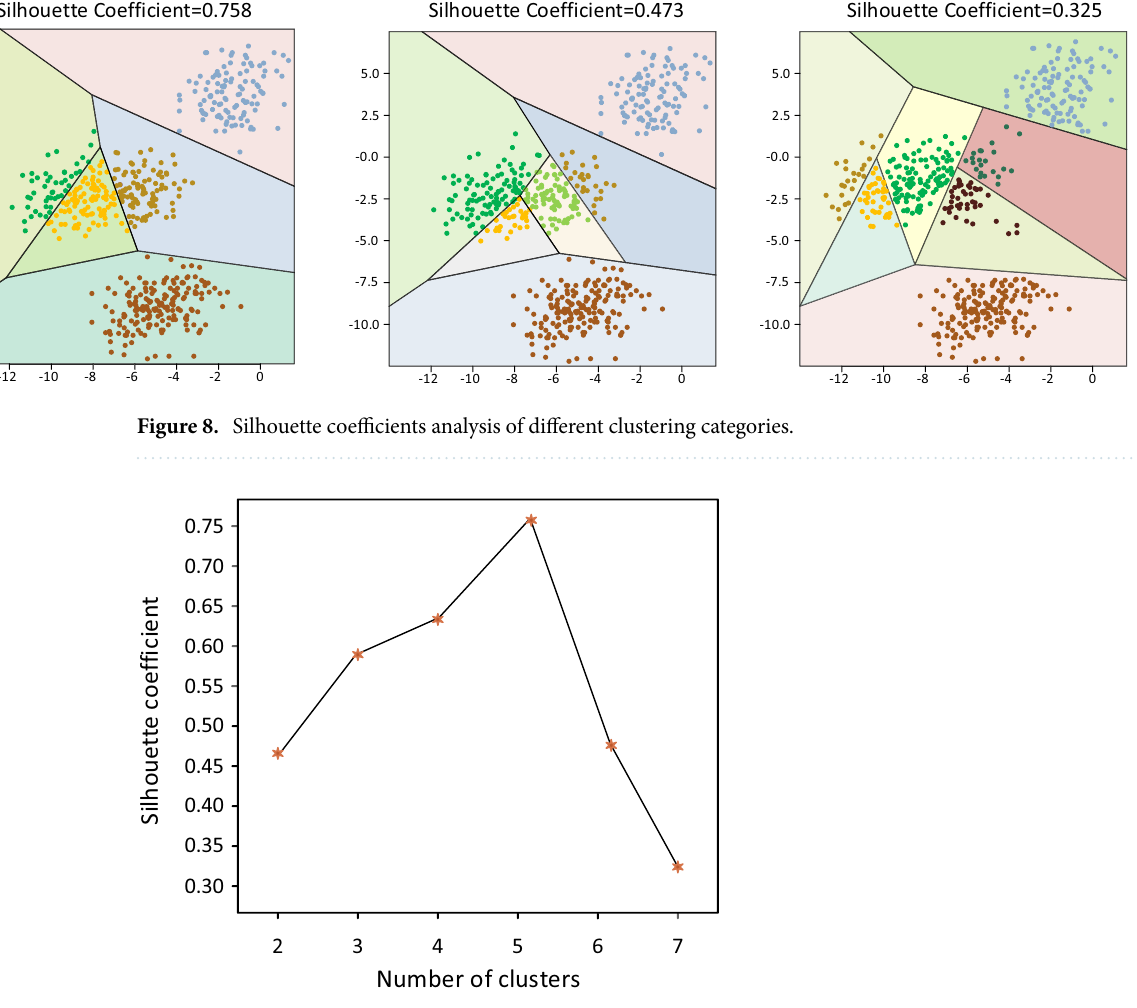
Figure 9. The relation curve between the Silhouette coefficient and the number of different kinds of